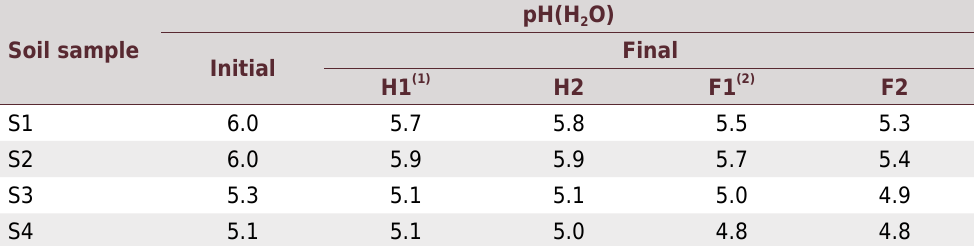
Table 3. Initial and final soil pH in water of soil samples from a multi-metal contaminated site after application of doses of humic acid and fulvic acid